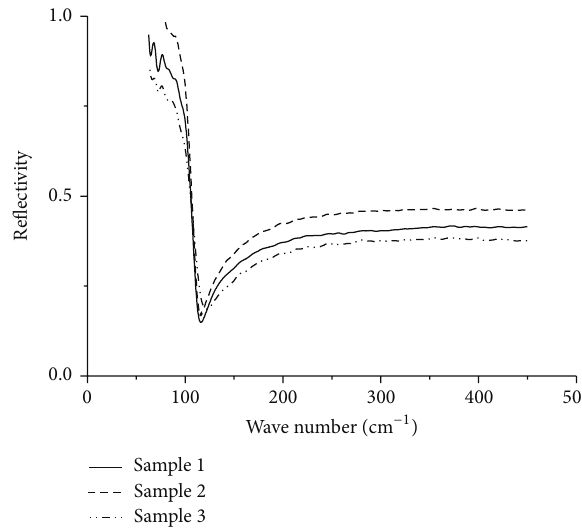
Figure 2: Room temperature FIR diagrams of PbTe doped with 3.3 at% Au (Sample 1, “beginning”), 1.7 at% Au (Sample 2, “middle”), and 0.3 at% Au (Sample 3, “end”).